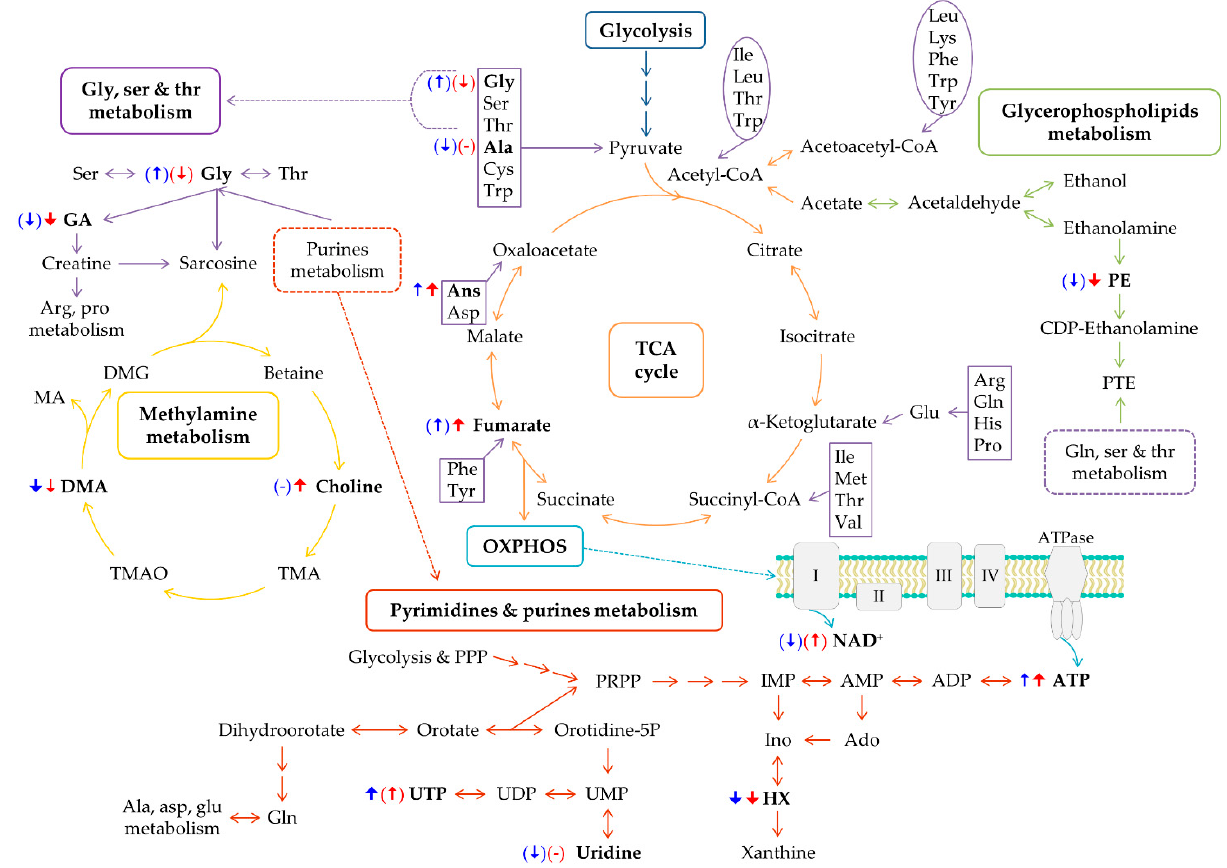
Figure 6. Metabolic pathways putatively identified as the main disturbances on the polar metabolome of TNBC tumors after the exposure to cDDP or Pd 2 Spm complex. The blue and red arrows illustrate the direction of variation, distinguishing each treated mice group, with blue for cDDP and red for Pd 2 Spm, while arrow width is proportional to the statistical significance (ES and p -value) of each variation compared to control levels; arrows in brackets represent variations that are not statistical relevant ( p -value > 0.05). Amino acids involved in anapleurotic reactions and classified as ketogenic and glucogenic are represented in circles and rectangles, respectively. Abbreviations: Ado, adenosine; DMG, dimethylglycine; IMP, inosine monophosphate; MA, methylamine; OXPHOS, oxidative phosphorylation; PPP, pentose phosphate pathway; PRPP, phosphoribosyl diphosphate; PTE, phosphatidylethanolamine; TMA, trimethylamine; TMAO, trimethylamine N -oxide; UDP, uridine diphosphate; UMP, uridine monophosphate. Other metabolite abbreviations are defined in the captions of Figures 1 and 3.